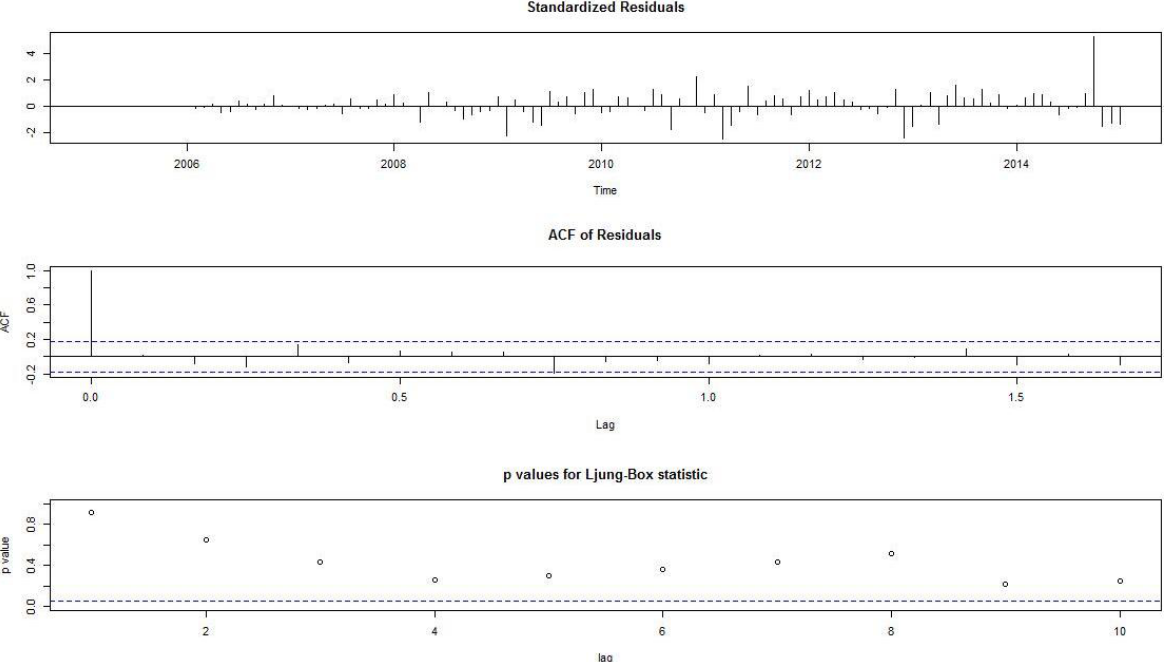
Fig. 7. Analysis of residuals of the model